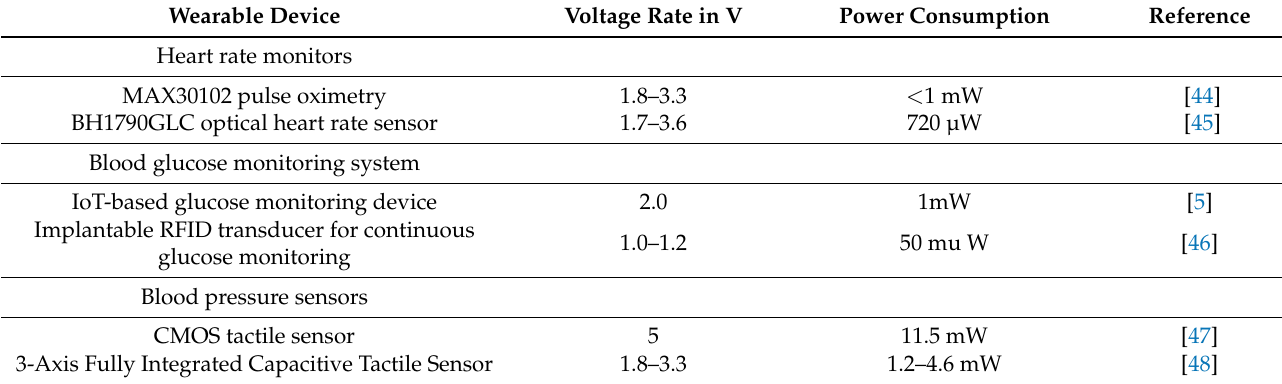
Table 6. Energy consumption of typical wearable devices.